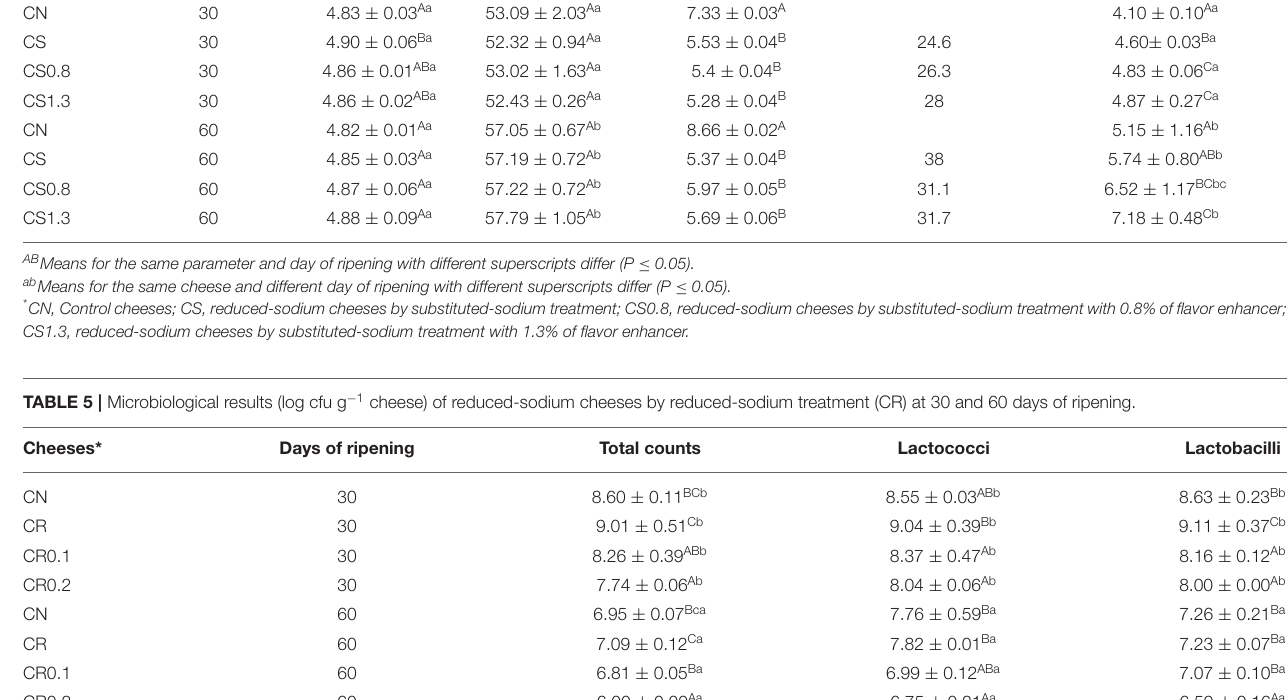
TABLE 4 | Composition of substituted-sodium cheeses (CS) at 30 and 60 of ripening. Cheeses Days of ripening